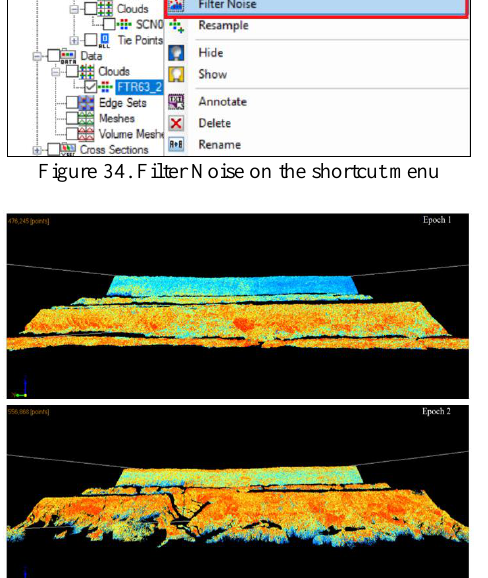
Figure 35. The selected slope area after the data cleaning for epoch 1 and